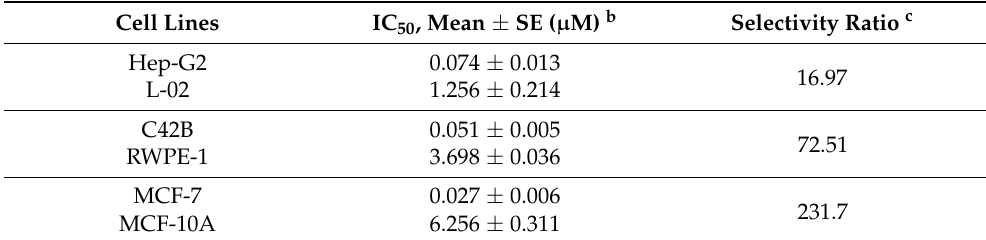
Table 2. Cytotoxicity selectivity of compound 14b toward human non-tumorigenic cell lines and cancer cell lines a .